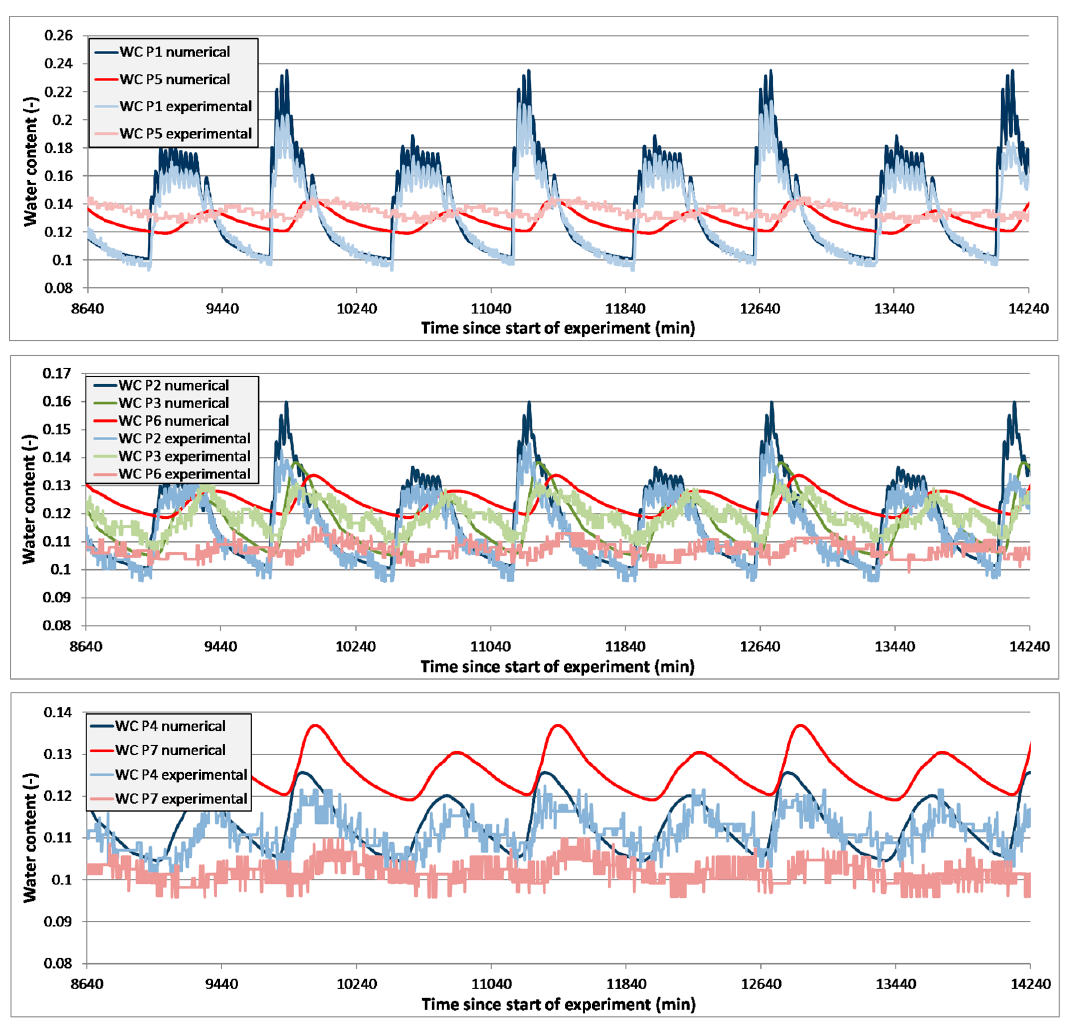
Figure 2. Results for water content simulation for scenario WW-Ref (sep.) as compared to observed values in the laboratory tank experiment for the time of 8640 to 14,240 min. after the onset of numerical experiment.